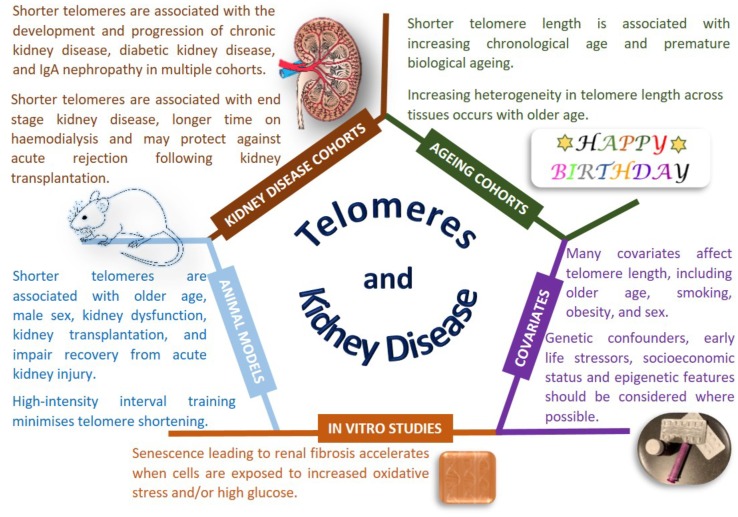
Telomeres and kidney disease. Copyright disclosure: mouse: https://commons.wikimedia.org/wiki/File:Vector_diagram_of_laboratory_mouse_%28black_and_white%29.svg; https://creativecommons.org/licenses/by-sa/4.0/deed.en; attribution, “By Gwilz [CC BY-SA 4.0 (https://creativecommons.org/licenses/by-sa/4.0)], from Wikimedia Commons. Kidney: https://commons.wikimedia.org/wiki/File:Kidney_Cross_Section.png; By Artwork by Holly Fischer [CC BY 3.0 (https://creativecommons.org/licenses/by/3.0)], via Wikimedia Commons.